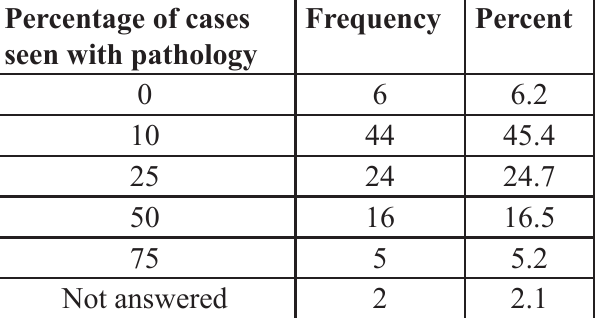
Percentage of cases